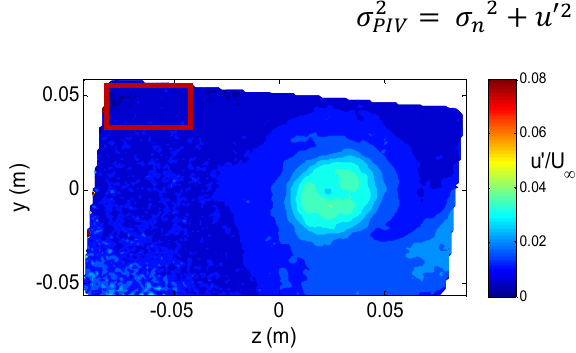
Figure 3 - Contour plot of turbulence intensity. The boxed area is the region in which the total variance was taken to calculate the PIV random